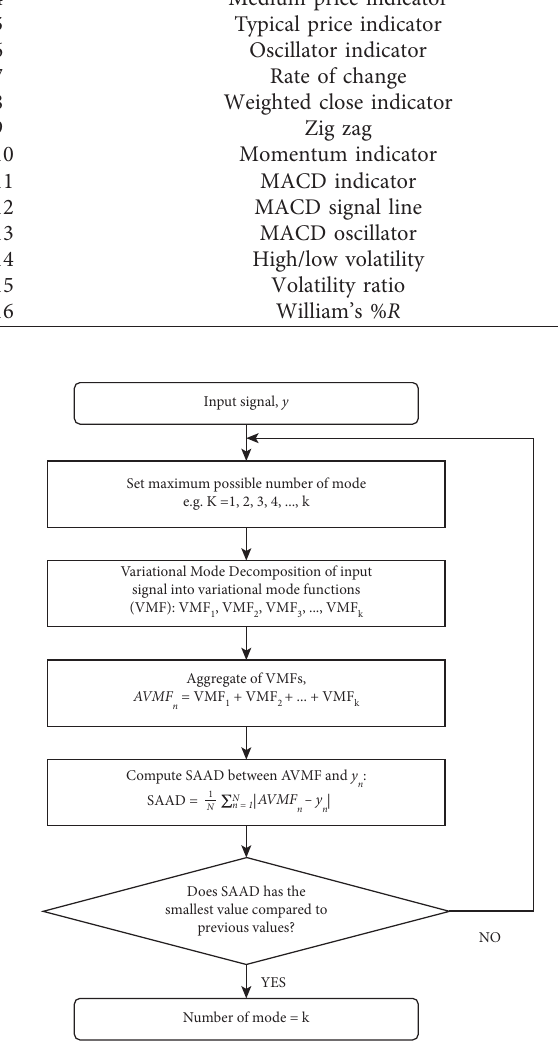
Figure 1: Proposed reconstruction of variational mode